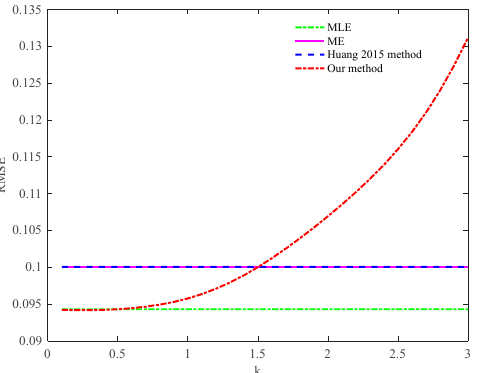
Figure 7. The relationship between k and RMSE in the data of simulated log–normal distribution. When k = 0.1 ∼ 0.4, the RMSE of the proposed method is smaller than that in MLE; 2. The measured data experiment. In order to further verify the effectiveness of the proposed method, 107 groups of measured IPIX data with a length of 256 points are mod- eled and analyzed, and the parameters of the different methods are estimated, respec- tively. The estimation accuracy of the RMSE is shown in Table 6.